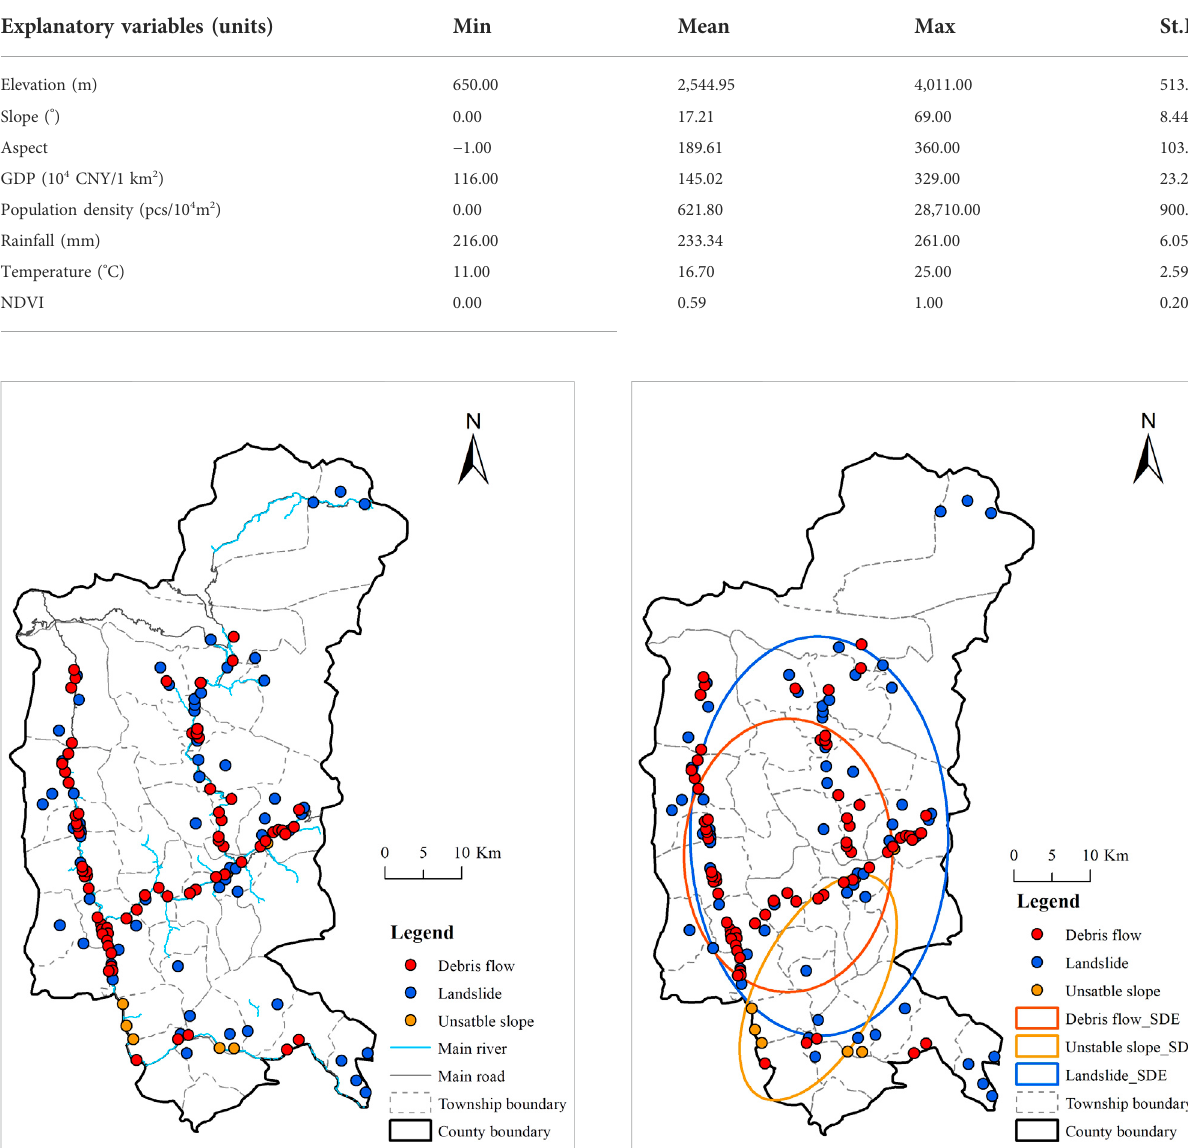
FIGURE 5 Location of PGDSs.